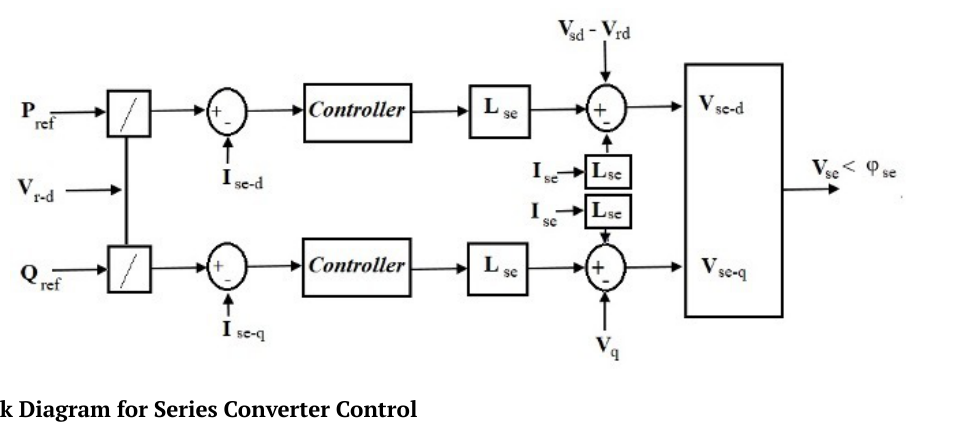
Figure 5. Block Diagram for Series Converter Control are passed through the controllable, which produces, with respect to the bus voltage. The direct and the quadrature components of the series injection voltage V respectively, so, the magnitude of the series voltage and its phase angle and by adding a relative angle α